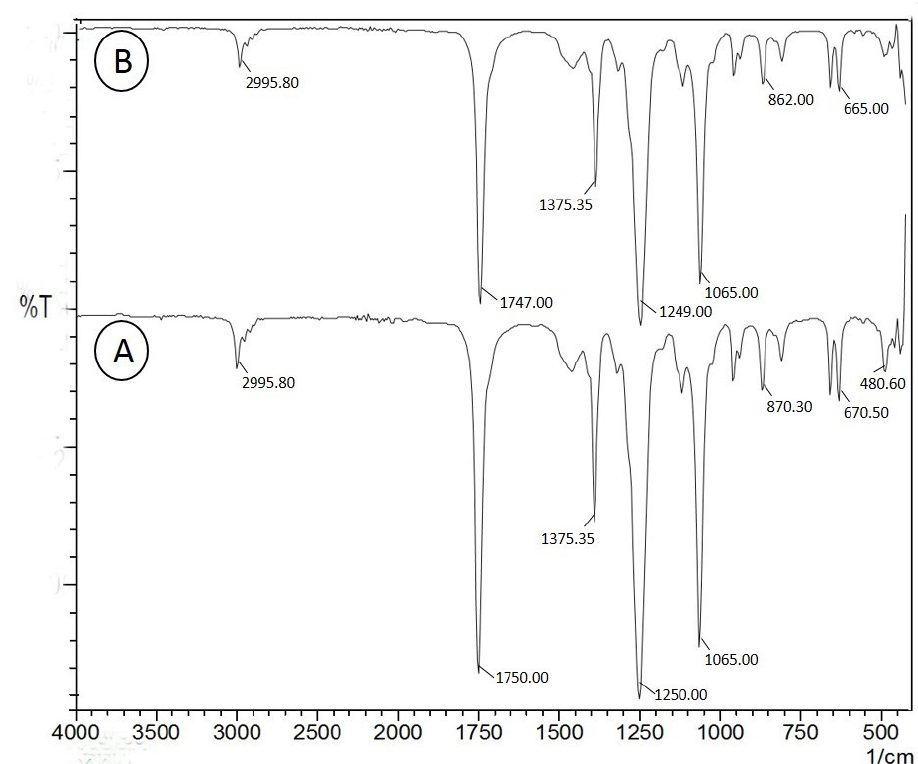
Figure 5. FT-IR spectra of Asian spider flower (Asf) plant extract ( A ) and AgNPs manufactured from Asf ( B ).